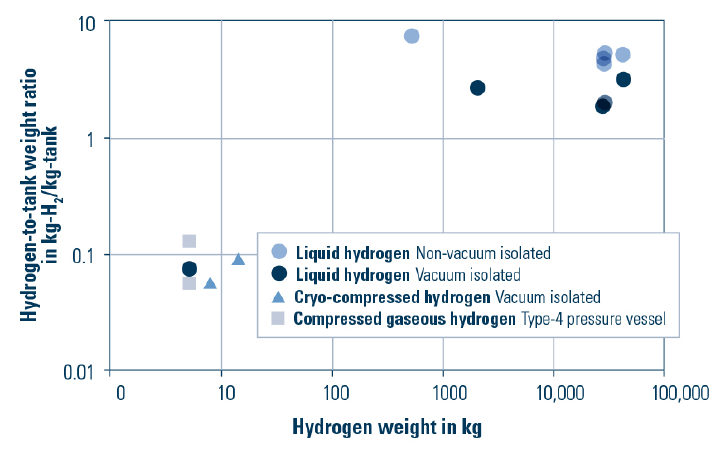
Figure 14. Comparison of various physical hydrogen storage options (source: Bauhaus Luftfahrt e.V. (https://www.bauhaus-luftfahrt.net/en/topthema/hy-shair/)).